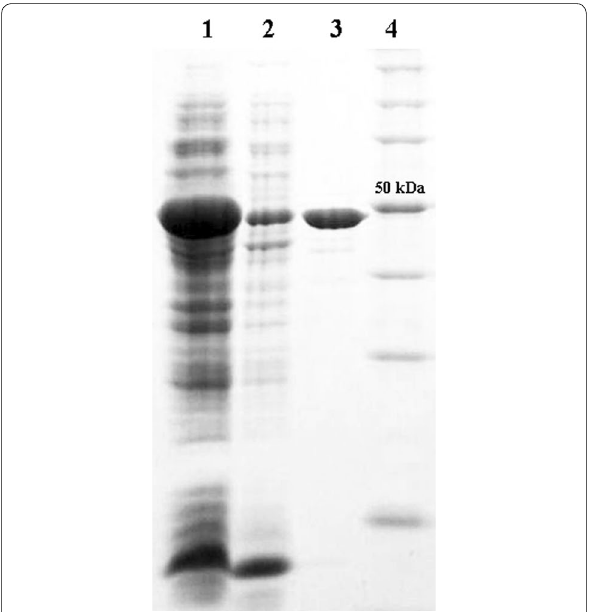
Fig. 1 Expression and purification of LAC_2.9. Denaturing gel was loaded with: 1—recombinant E. coli culture induced with 1 mM